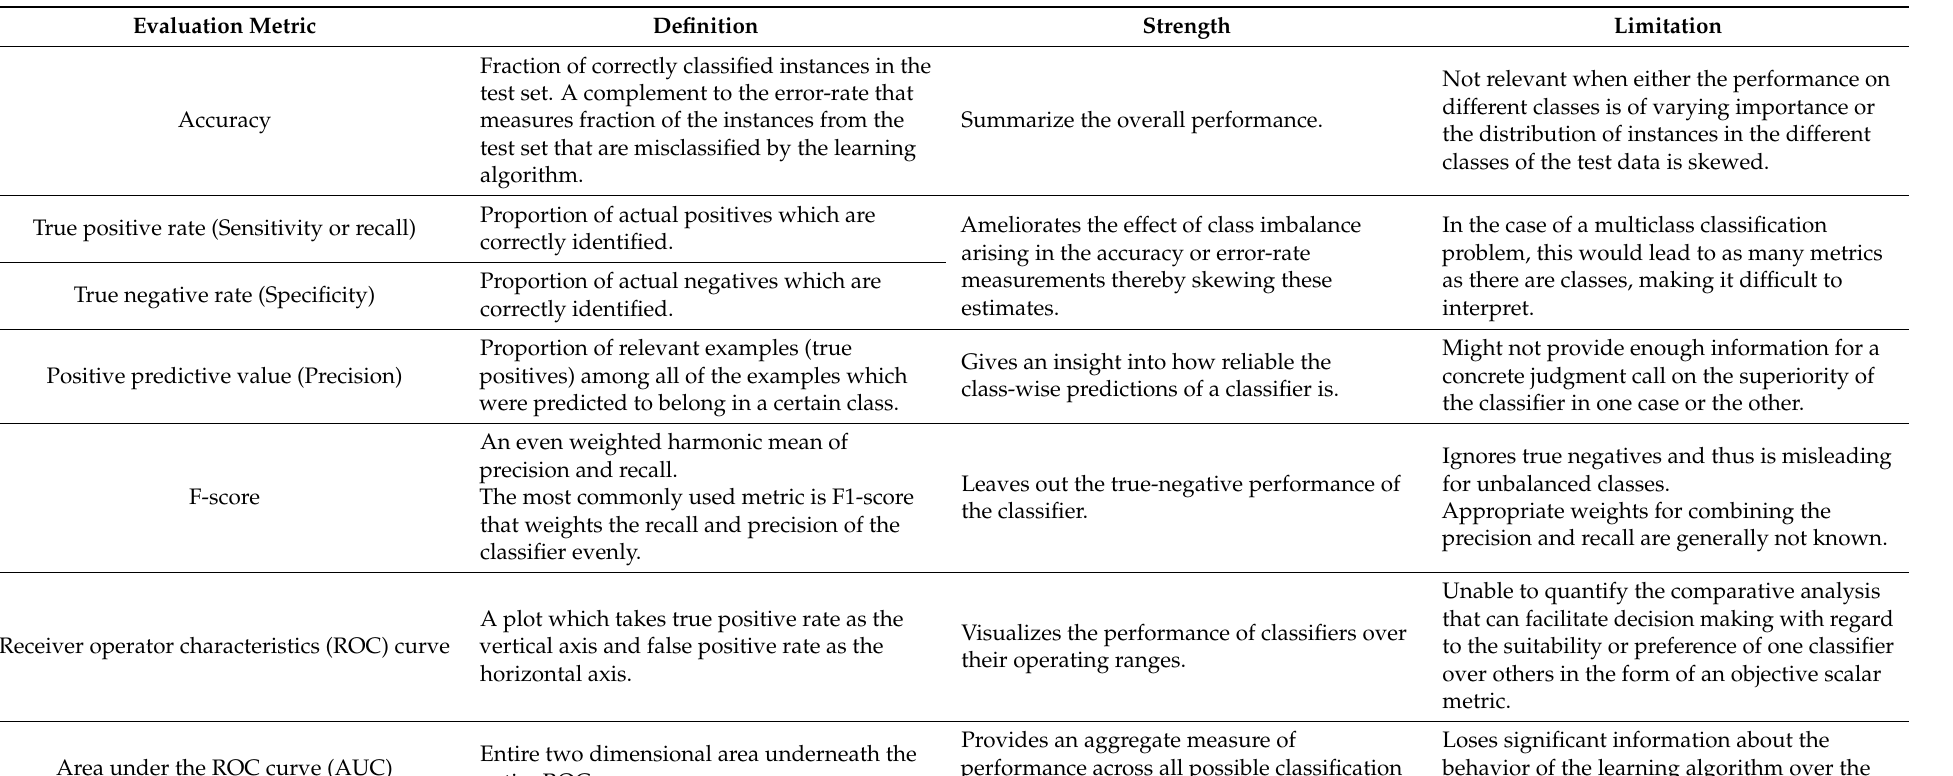
Table 7. Strengths and limitations of common evaluation metrics for classification performance of a DL